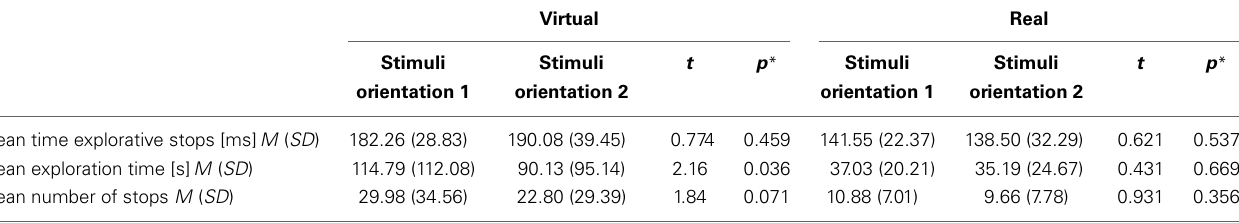
Table 3a | Description of experimental data from Experiment D (virtual) and Experiment E (real).